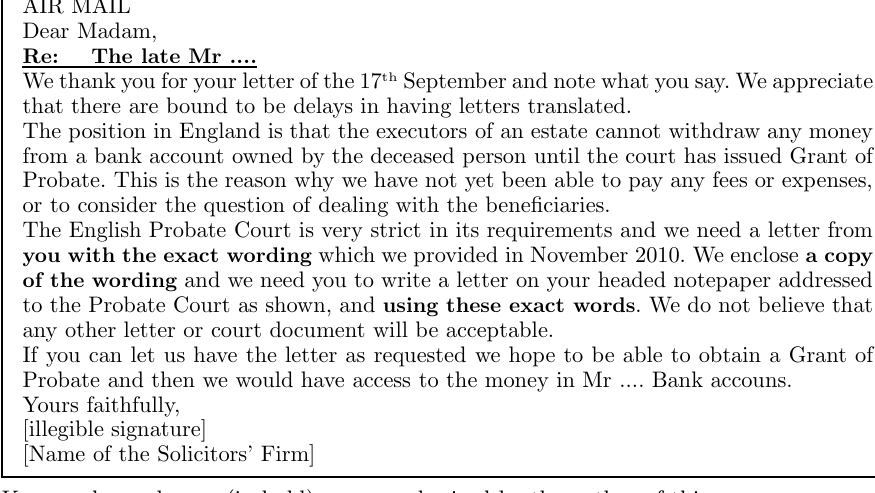
The second letter sent by the English solicitor in response to the translated Affidavit